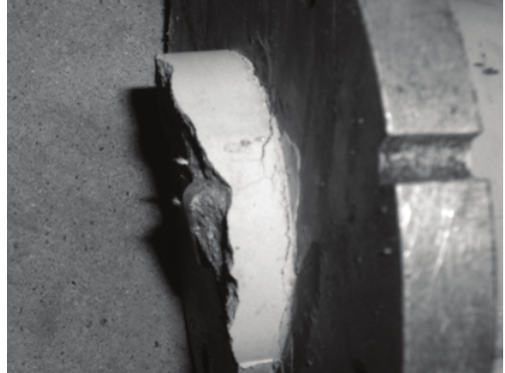
Figure 3: Typical failure within the end zone of the dog-bone- shaped specimen.